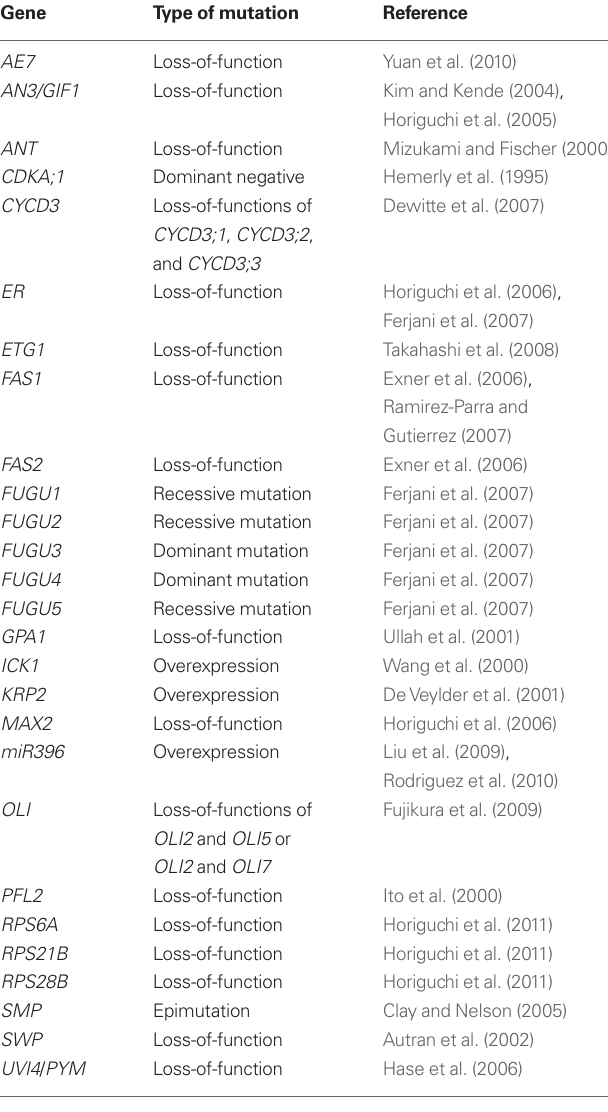
Table 1 | Examples of compensation-exhibiting mutants and transgenic